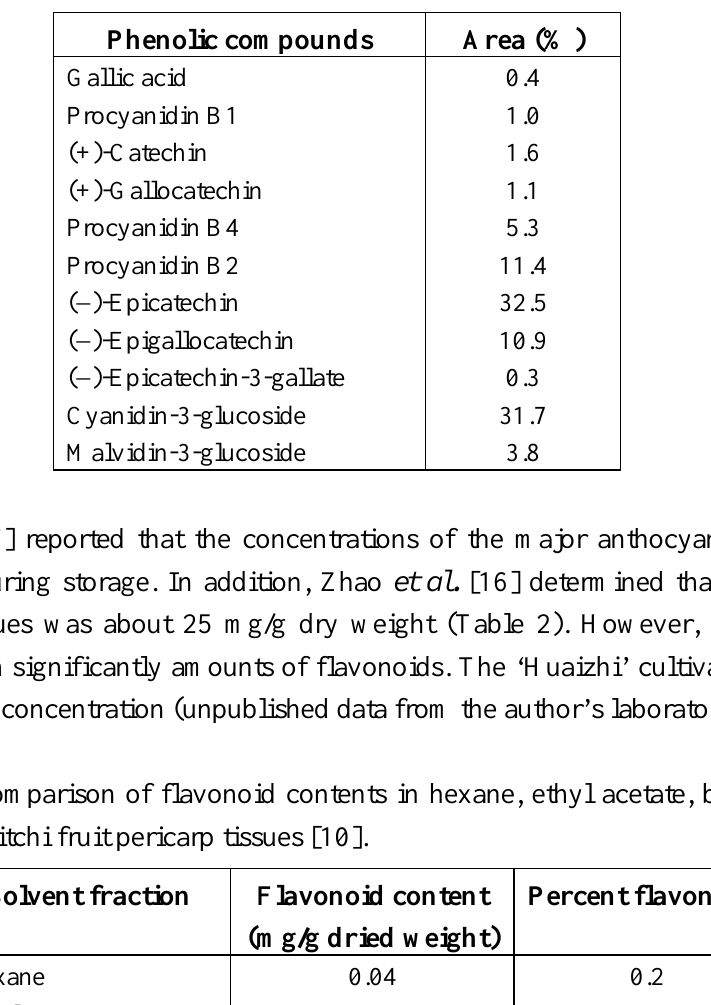
Table 1. Phenolic compounds and pigments in pericarp tissues of ‘Huaizhi’ fruit [17].